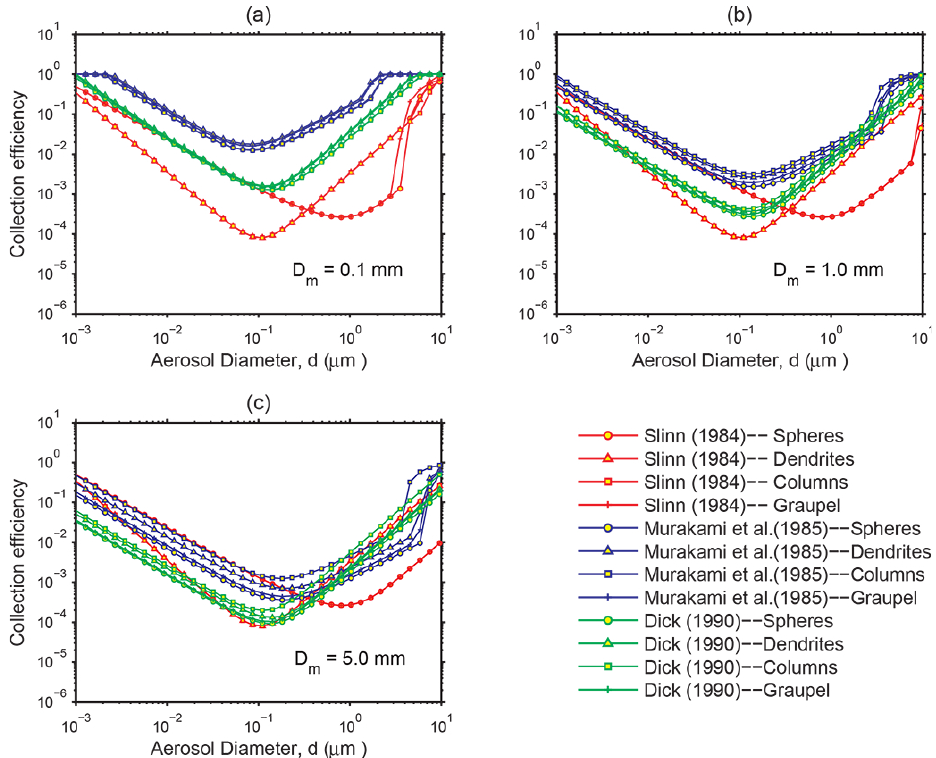
Fig. 1. Size-resolved snow collection efficiency profiles E(d p ,D p ) calculated using the three formulas listed in Table 1 (three different colours) for aerosol particles from 0.001 to 10µm in diameter collected by monodisperse snow particles of three different (frozen) sizes: (a) 0.1; (b) 1.0; and (c) 5.0mm. Four different snow-particle shapes are considered for each snow-particle size (different symbols in each colour group). Note in (a) , (b) and (c) the overlap of red triangle and red square and partial overlap of red circle and red cross; and in (a) the overlap of blue triangle and blue cross and the overlap of blue circle and blue